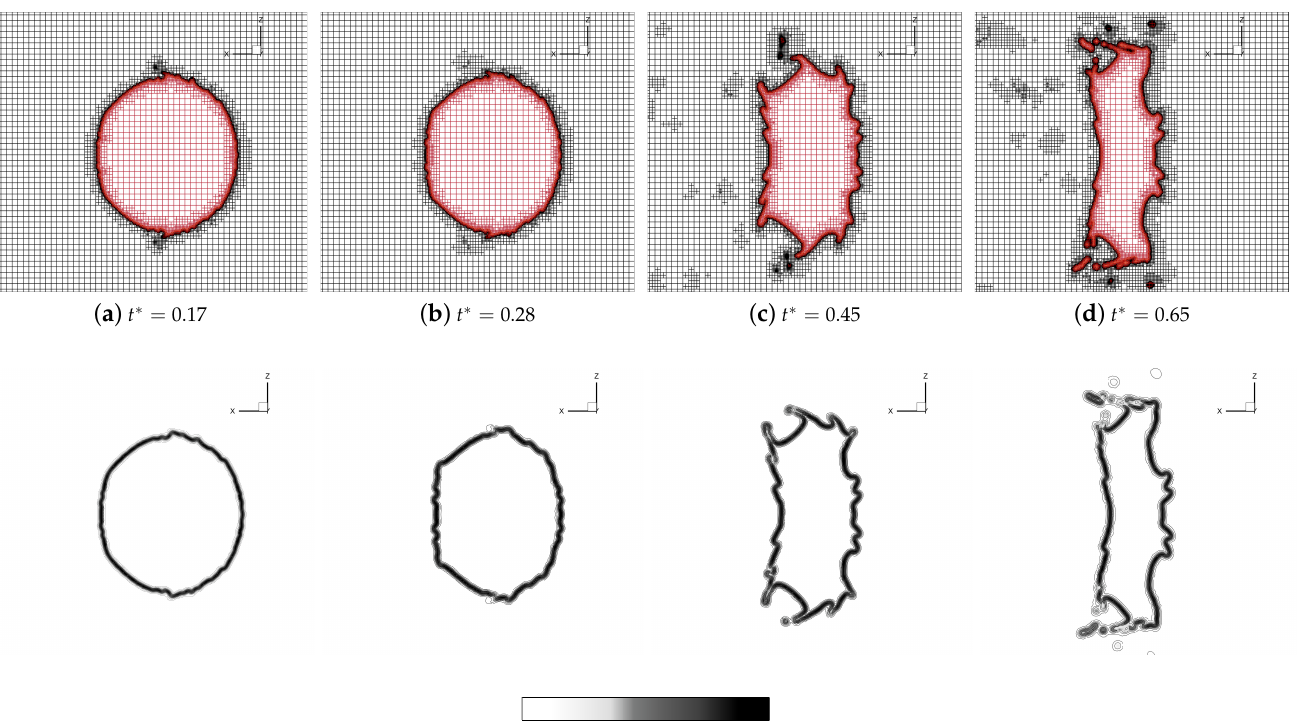
Figure 8. Plane views in the midplane y = 0 of adaptive numerical mesh ( top ) and corresponding contours of normalized volume fraction gradient magnitude ( bottom ) at four typical time